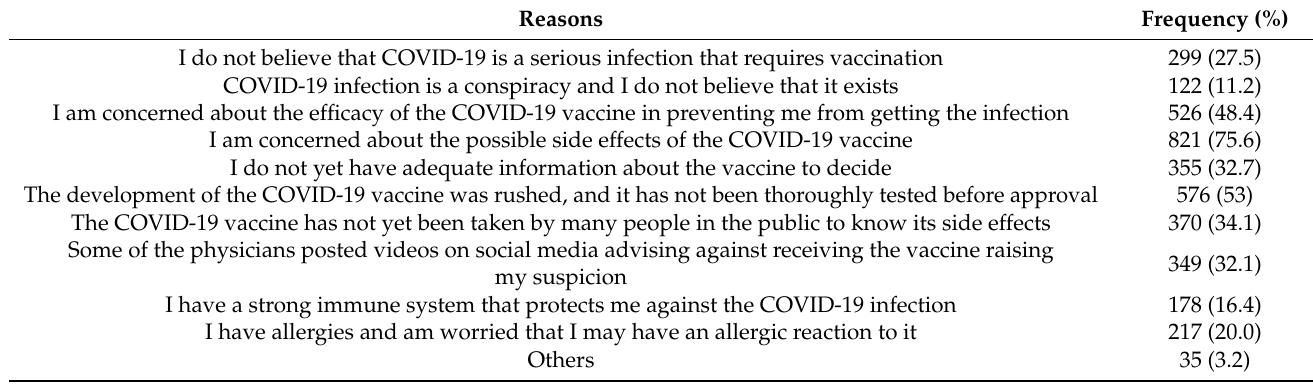
Table 3. Reasons for uncertainty or unwillingness to vaccinate ( n =